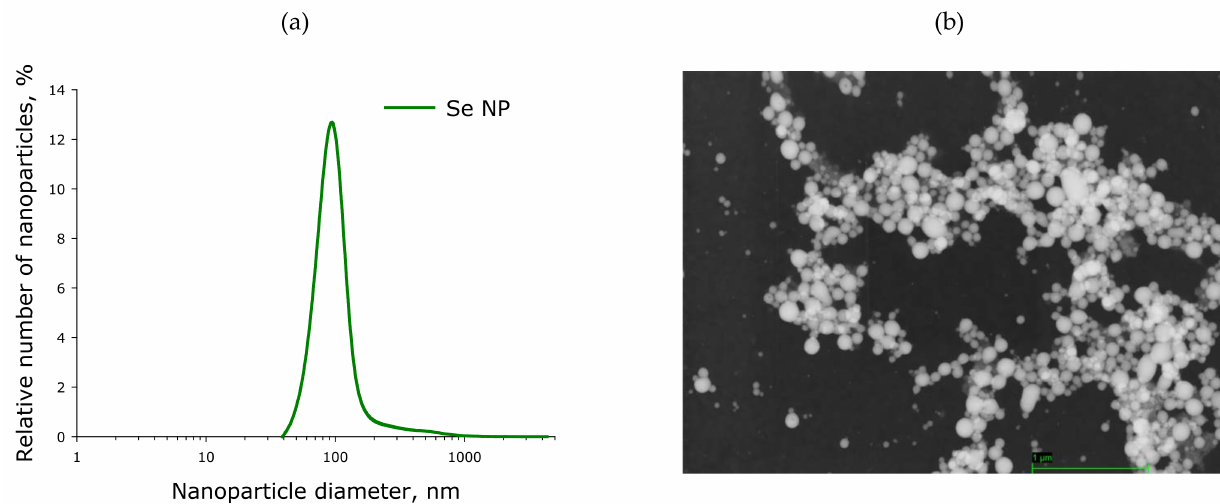
Figure 15. Size and morphology of SeNP obtained by laser ablation. ( a ) SeNP size distribution. Data obtained using an analytical disk centrifuge and confirmed by DLS. ( b ) TEM micrograph of selenium nanoparticles. Scale bar—1 µ